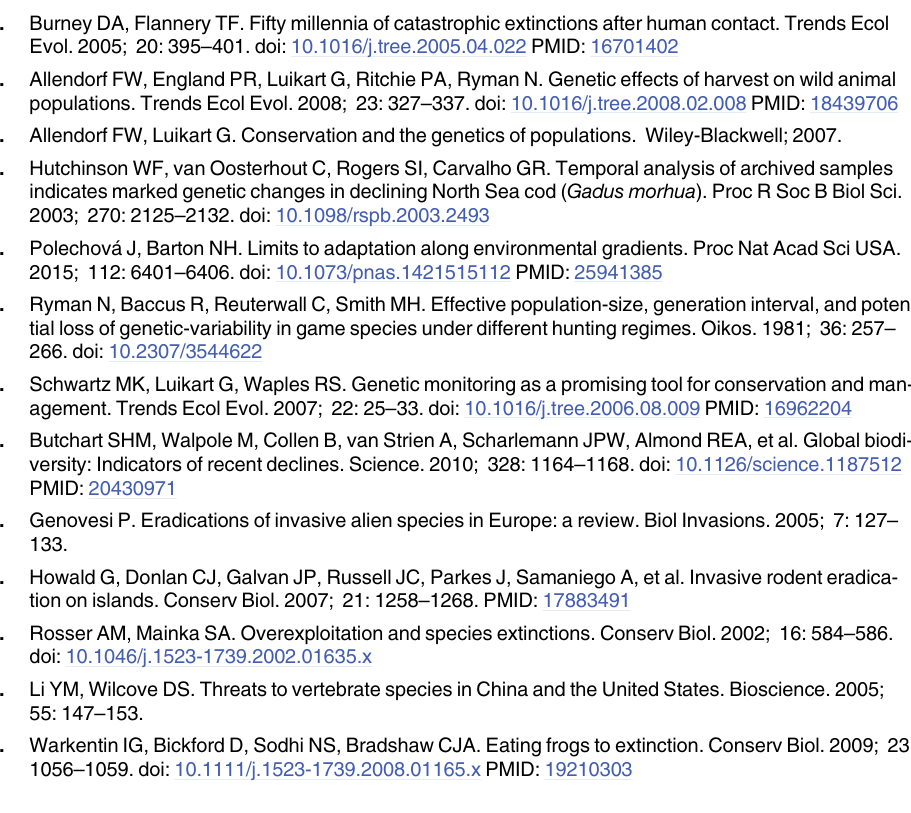
S1 Table. Pairwise F (below diagonal) and harmonic mean estimate D ST (above diagonal) comparison between samples taken from three sites (Koster Islands, North and South Coast) in Sweden in 2006 – 2011. Statistical significance for pairwise F given using the adjusted nominal level for multiple comparisons after Bonferroni correction. Sample sizes are given in parentheses. North Coast samples from 2008 and 2009 as well as from 2010 and 2011 were combined.